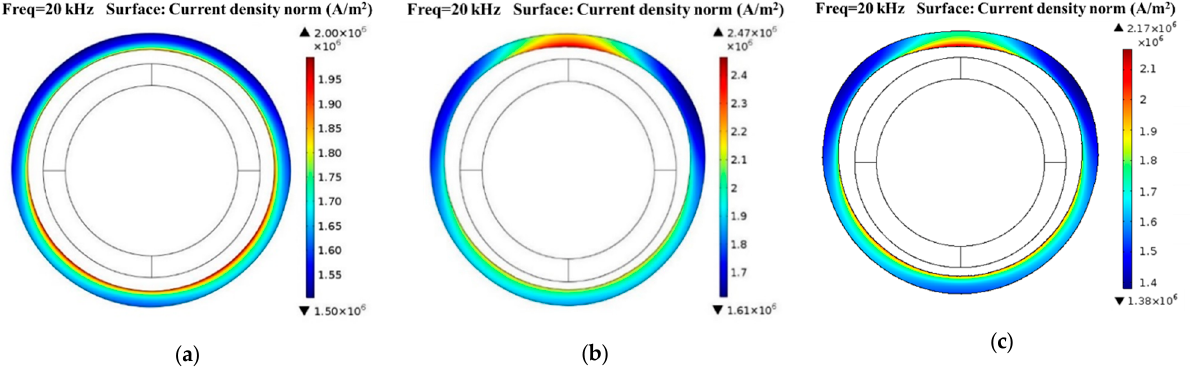
Figure 7. The results of the simulations of current density at angle positions: ( a ) 0°, ( b ) 29°, and ( c ) 45°.